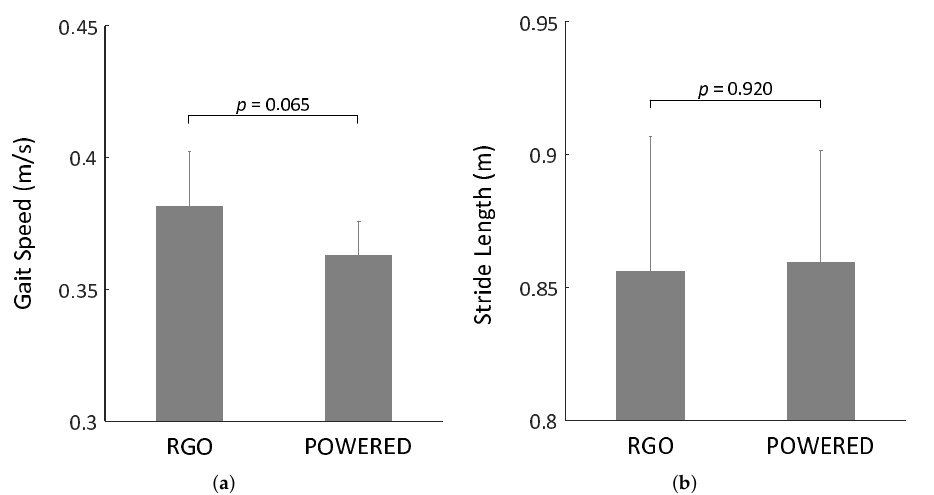
Figure 7. Spatiotemporal gait parameters: ( a ) gait speed and ( b ) stride length. Bars and error bars are means and standard deviations, respectively.